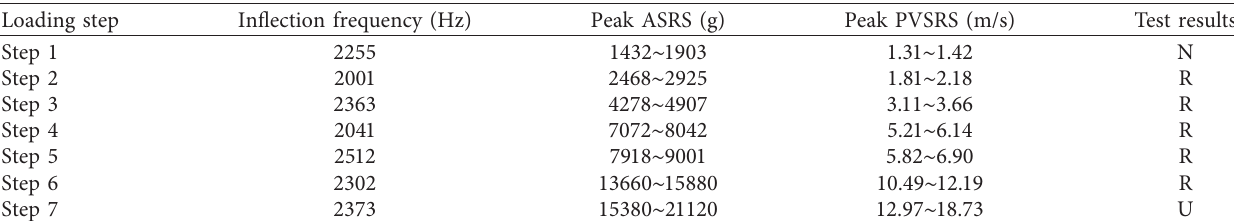
Table 6: Performance of crystal oscillators on the C2 board.